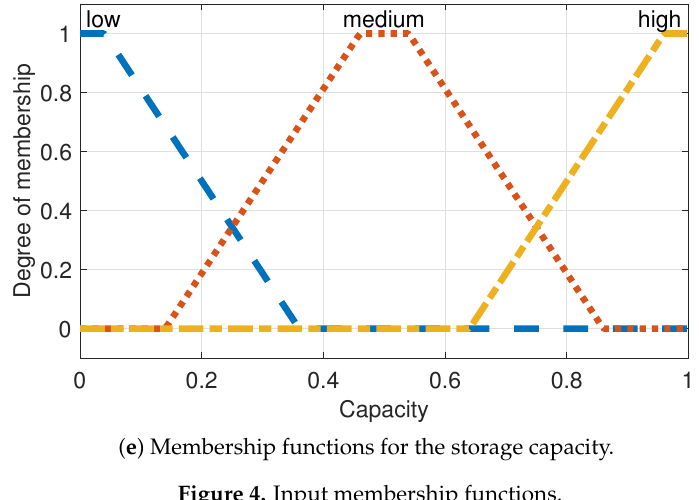
Figure 4. Input membership